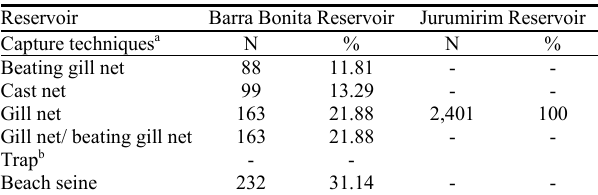
Table 4. Number (N) and frequency (%) of the use of capture techniques during fishing trips in the Barra Bonita and Jurumirim reservoirs in the period studied. a For details on the use of capture techniques, see Novaes & Carvalho (2009, 2011); b Occurred only in the Jurumirim Reservoir, see the explanation in the text Reservoir Barra Bonita Reservoir Jurumirim Reservoir Capture techniques a